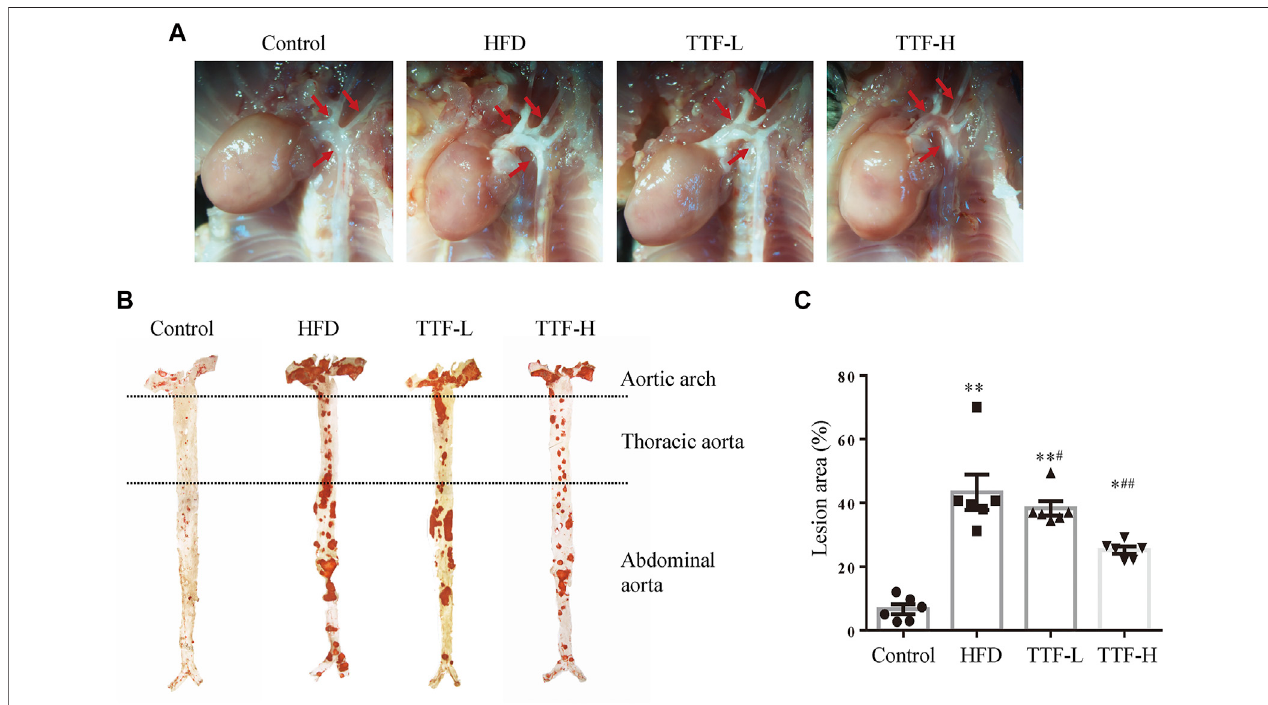
FIGURE3| TTFrelievesatheroscleroticplaqueinApoE -/- mice (A) Representative invivo imagesofaorticarchofApoE -/- mice.Thearrowspointthelocationofthe ASplaque (B) Theoil-red-Ostainingofenfaceaortaand (C) thequantitativeanalysisofatheroscleroticlesionareaofwholeaorta.Valuesarepresentedasmeans ± SEM (n (cid:2) 6 per group). * p < 0.05 vs Control group, ** p < 0.01 vs Control group, # p < 0.05 vs HFD group, ## p < 0.01 vs HFD group.